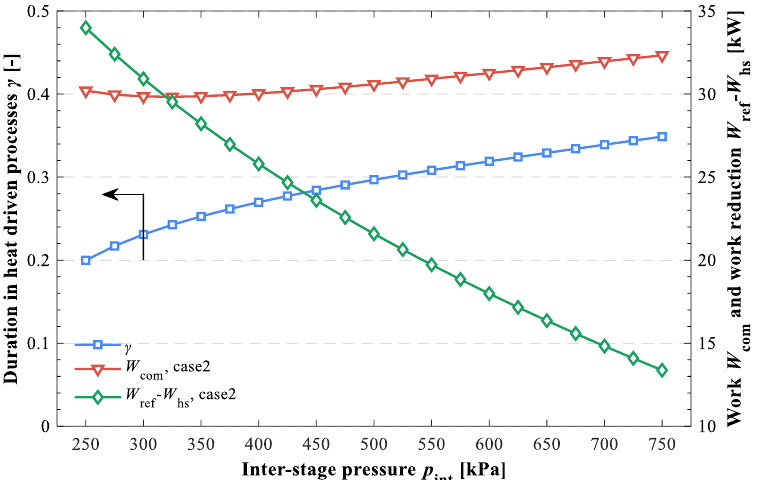
Figure 7. Effect of inter-stage pressure for two-stage cycle with thermal and mechanical compression processes in case 2.